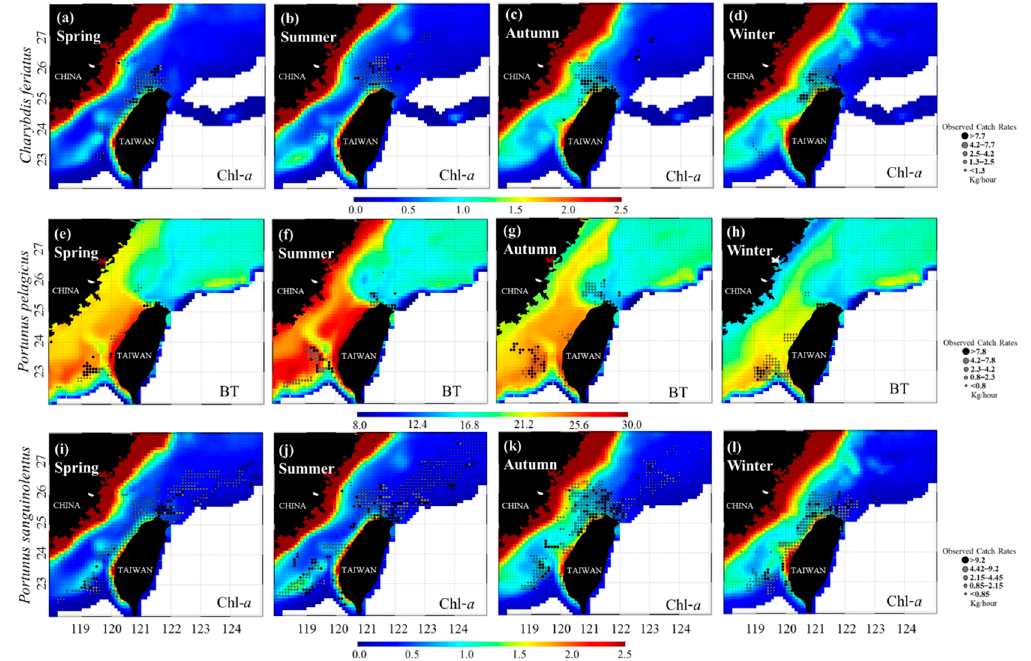
Figure 4. Seasonal mean observed catch rates of C. feriatus , P. pelagicus , and P. sanguinolentus during spring, summer, autumn, and winter, 2011–2016, overlaid with Chl- a ( a )–( d ),( i )–( l ) and BT ( e )–( h ).